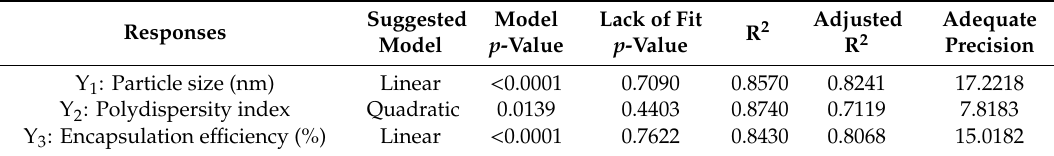
Table 2. Statistical parameters for suggested models of